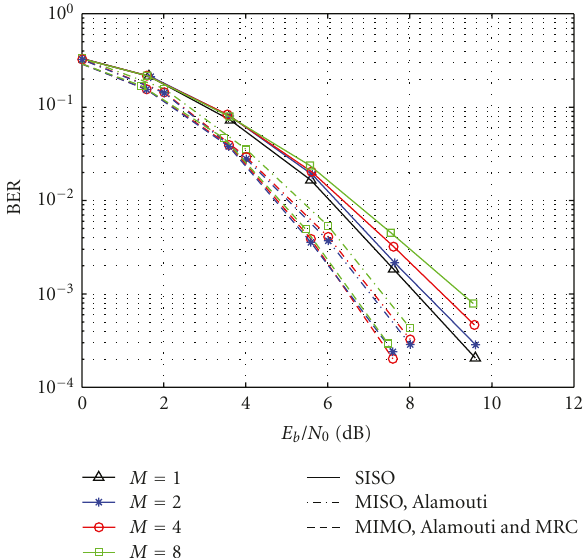
Figure 5: Coded performance for B-IFDMA with instantaneous data rate 4.44 Mbps, that is, Q = 128 subcarriers per user with normalized antenna gain.